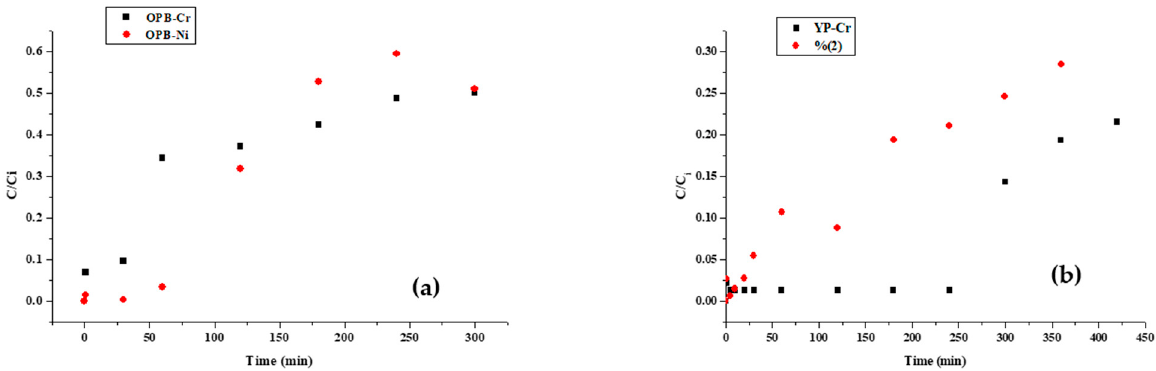
Figure 7. Breakage curve for the adsorption of Cr(VI) and Ni(II) on ( a ) OPB and ( b ) YP.